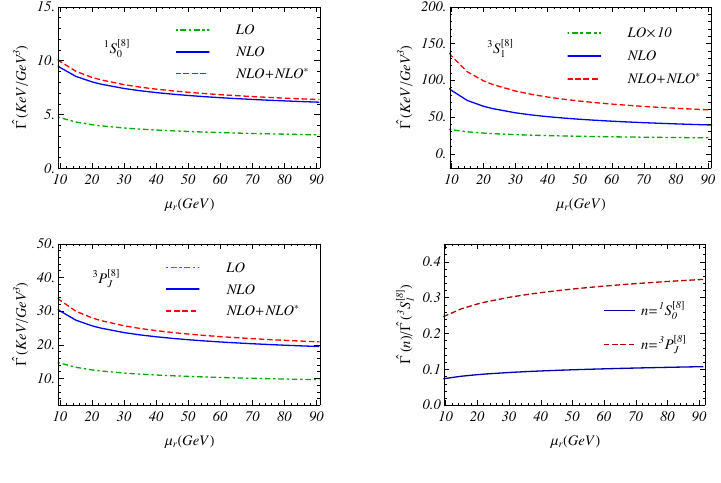
elucidating the ratio of these two channels. In b ¯ b